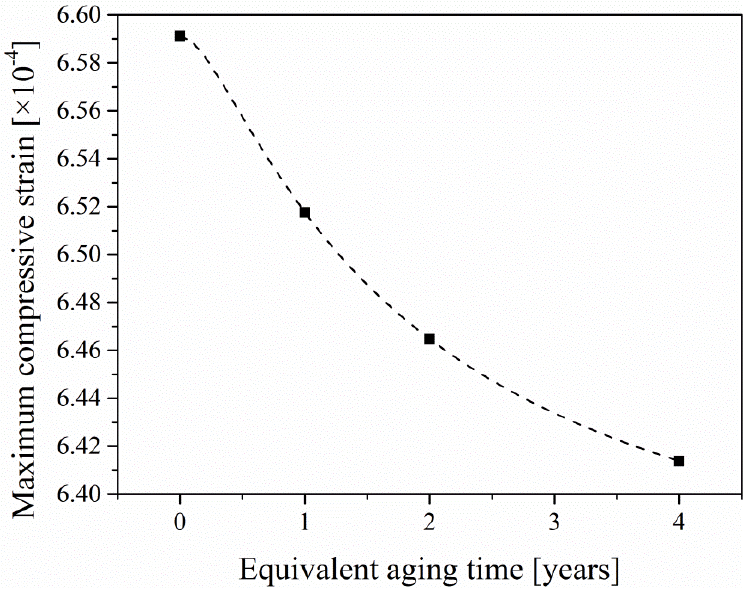
Figure 12. The maximum compressive strain–equivalent aging time curve. Materials 2019 , 12 , x FOR PEER REVIEW